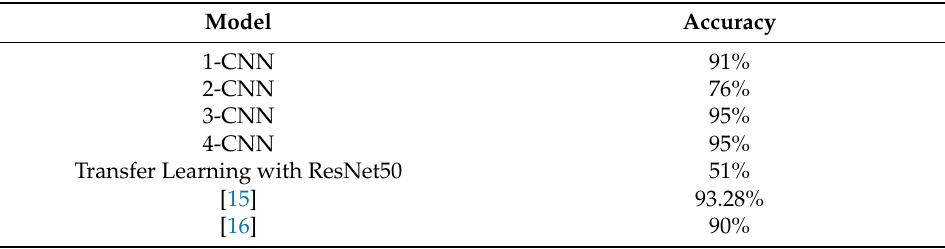
Table 3. Comparison value of accuracy for each